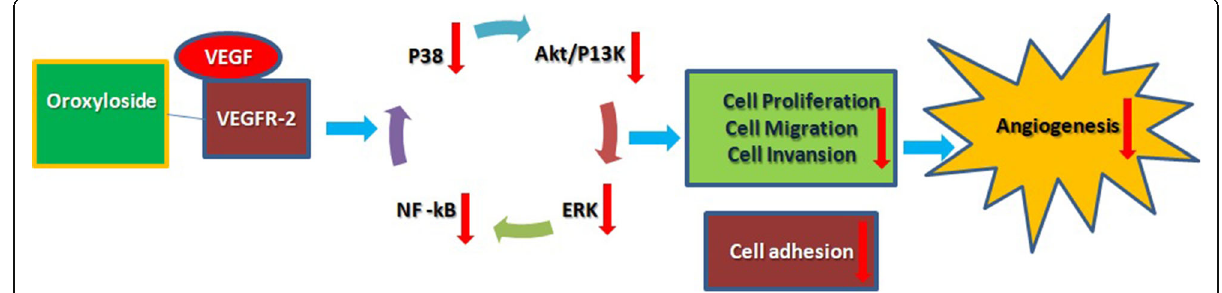
Fig. 4 A graphical representation describing the molecular mechanism of oroxyloside on the antiangiogenic activity in EA.hy926 cells